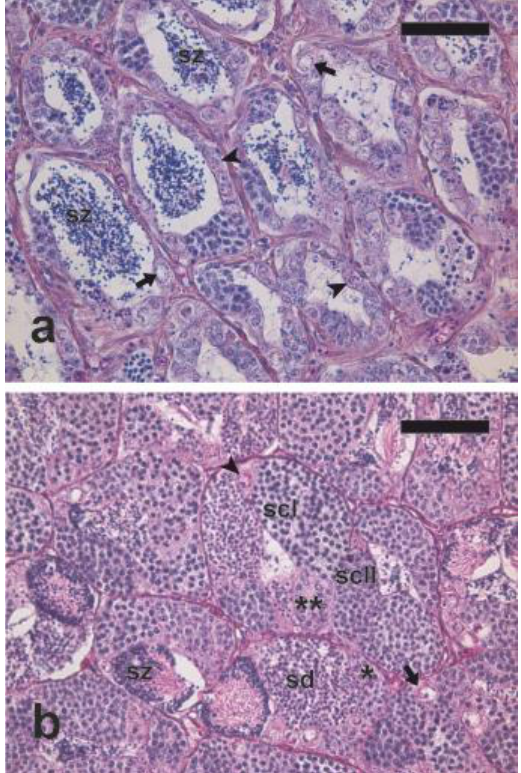
Figure 1. Micrographs of testis sections of meagre sampled in two periods of the reproductive cycle. ( a ) Testis section from a fish in post-reproductive state (mid-July 2017, Trial 1). The germinal epithelium is mainly constituted by spermatogonia and residual spermatozoa are visible in the lumen of the seminiferous lobules. ( b ) Testis section from a fish in active spermatogenesis (mid-March 2018, Trial 2) showing all stages of spermatogenesis. Haematoxylin–eosin (H-E) staining. Magnification bars = 50 µ m. Arrows: large single A spermatogonia; arrowheads: small single A spermatogonia; asterisk: Type A spermatogonial cyst; double asterisk: Type B spermatogonial cyst; sd: spermatid cyst; scI: primary spermatocyte cyst; scII: secondary spermatocyte cyst; sz: spermatozoa.